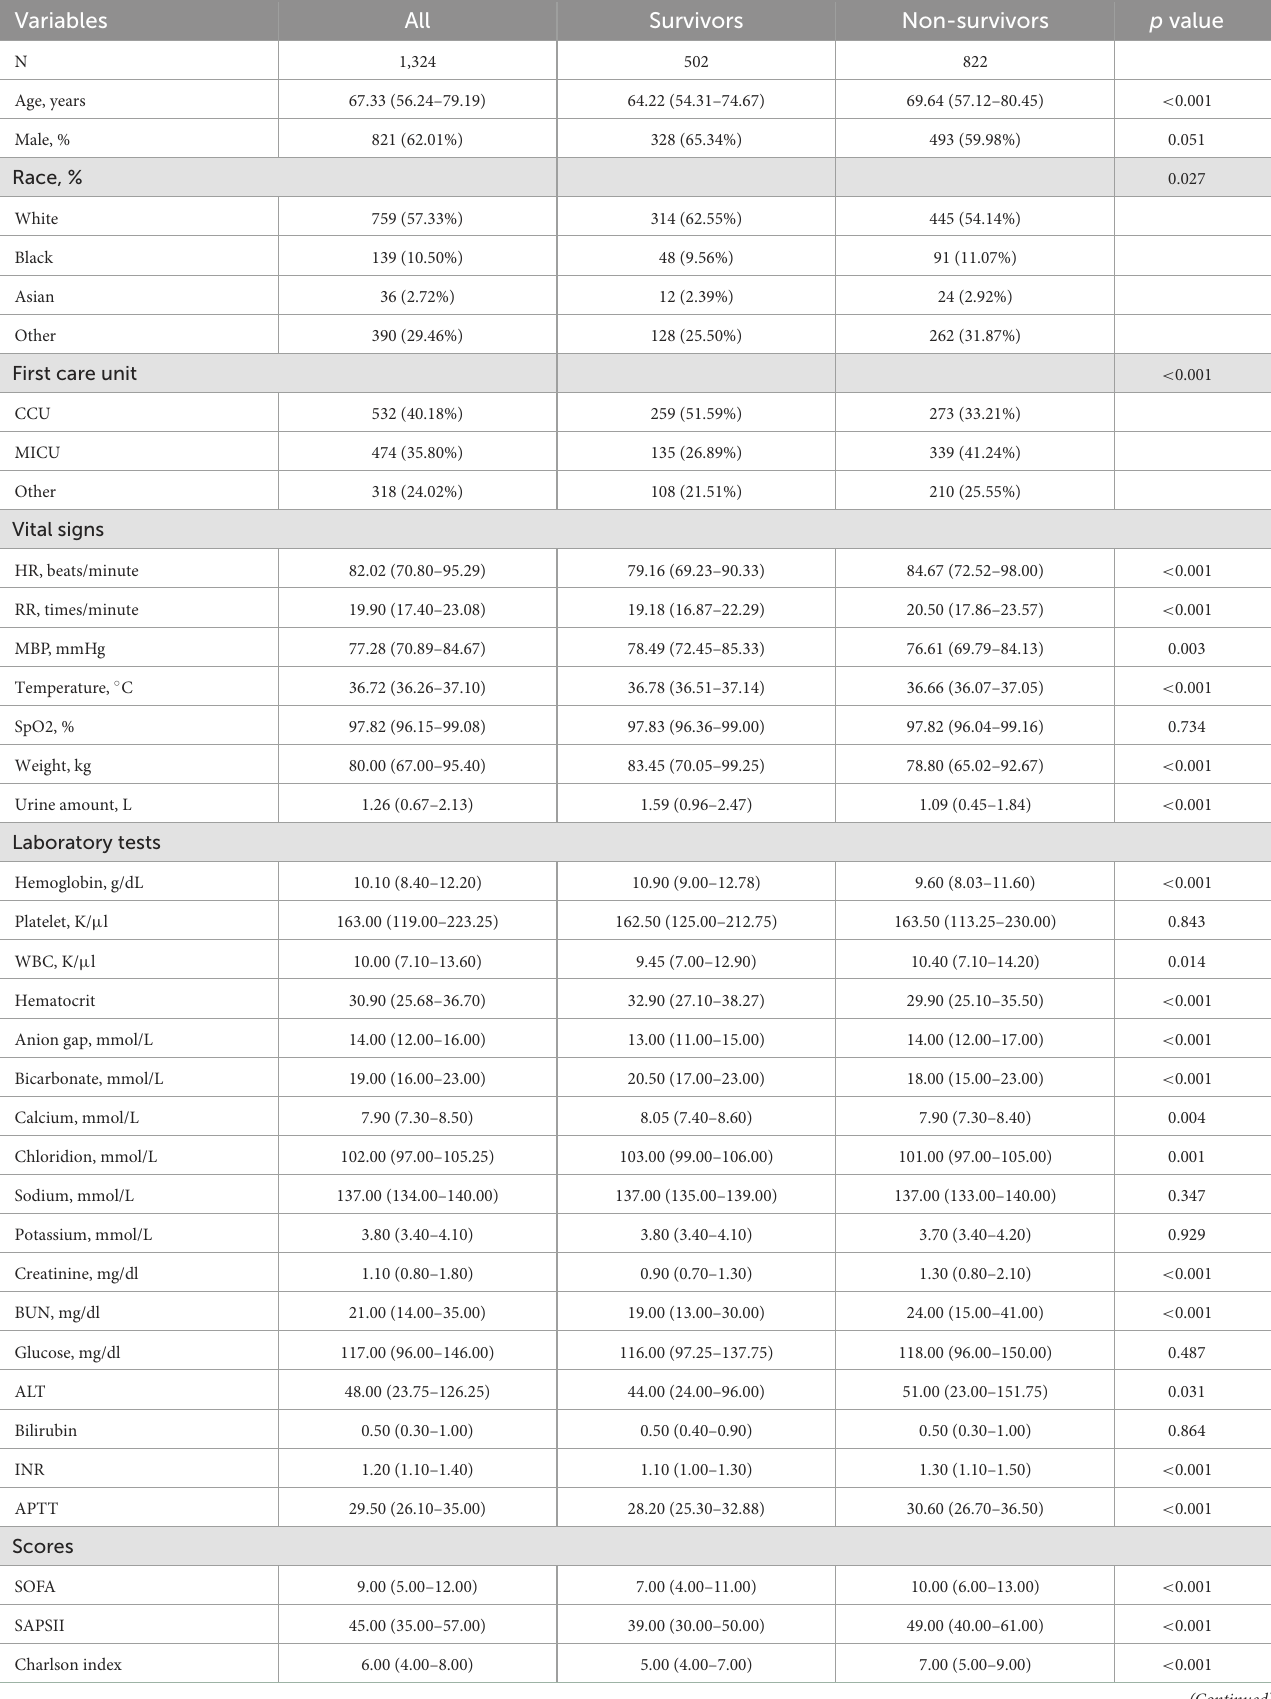
TABLE 1 Comparisons of the baseline characteristics between survivors and non-survivors at 1-year follow-up in the training